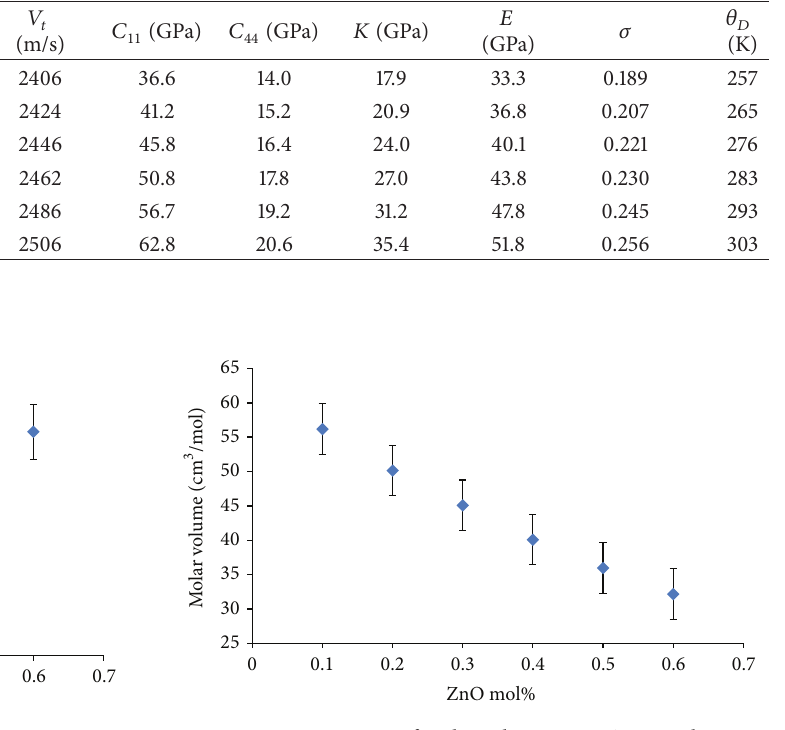
Figure 2: Variation of molar volume versus ZnO